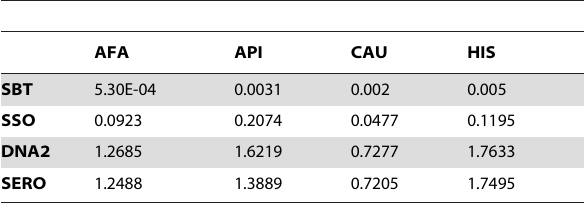
Table 5. Average haplotype entropy for all typing methods and all population